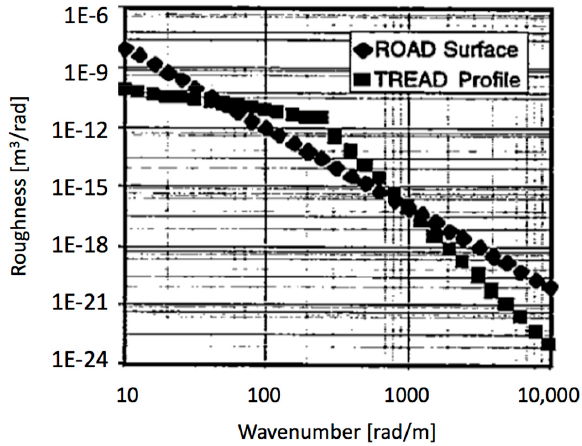
Figure 23. Pavement texture PSD (Power Spectral Density) and tread profile PSD (modified from Bremner et al., 1997 [67], Figure